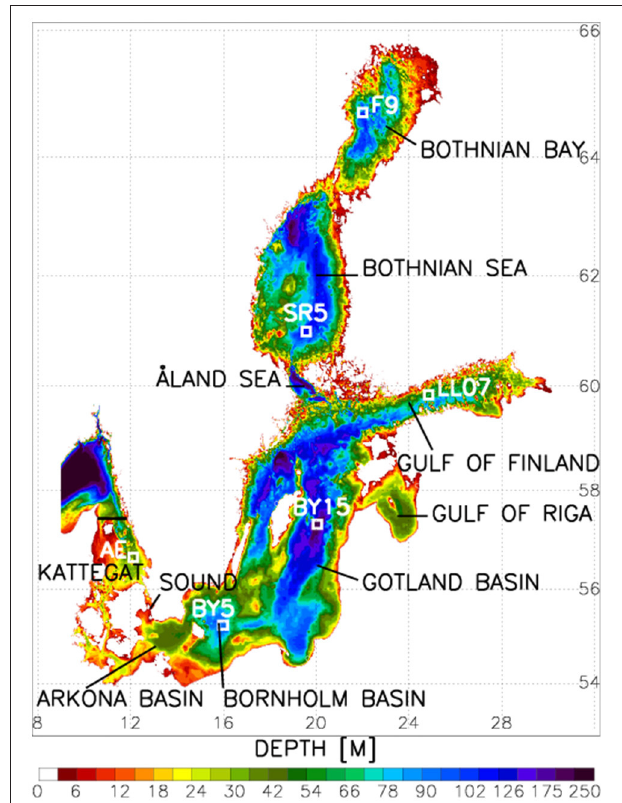
FIGURE 1 | Bottom topography of the Baltic Sea and locations of the monitoring stations Anholt East in Kattegat (AE), Bornholm Deep (BY5), Gotland Deep (BY15), LL07 in the Gulf of Finland, SR5 in the Bothnian Sea and F9 in the Bothnian Bay. The Baltic proper comprises the Arkona Basin, Bornholm Basin and Gotland